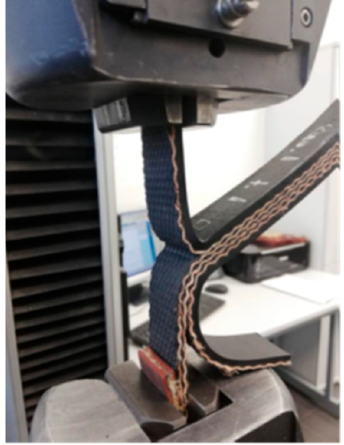
Figure 7. Delamination between ply 1 and ply 2.